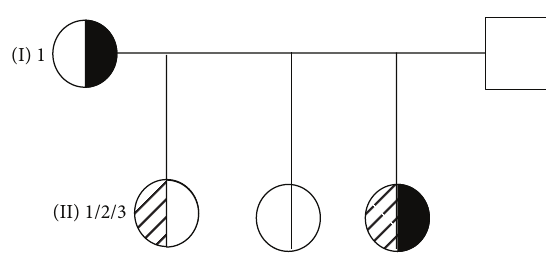
Figure 1: Pedigree . Full half circle: heterozygosity G87R SLC30A2; hatchedcircle:clinicalsignsduringinfancywhilebreastfed.II .1 ,II .2 , and II .3 were breastfed for 3, 1, and 6 months, respectively. II .3 is reported and